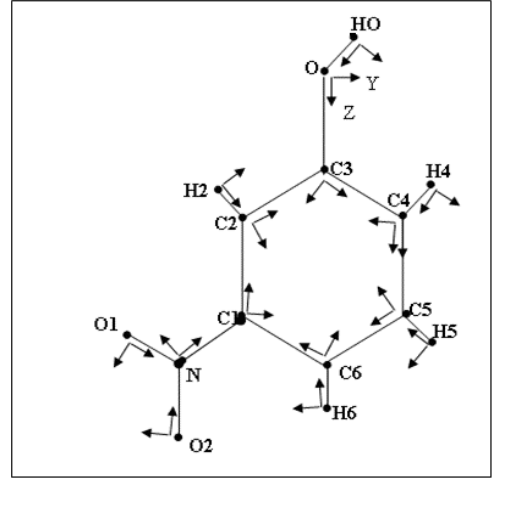
Figure 1. Labeling of the atoms and definition of local orthogonal reference axes for the atom-centered multipolar